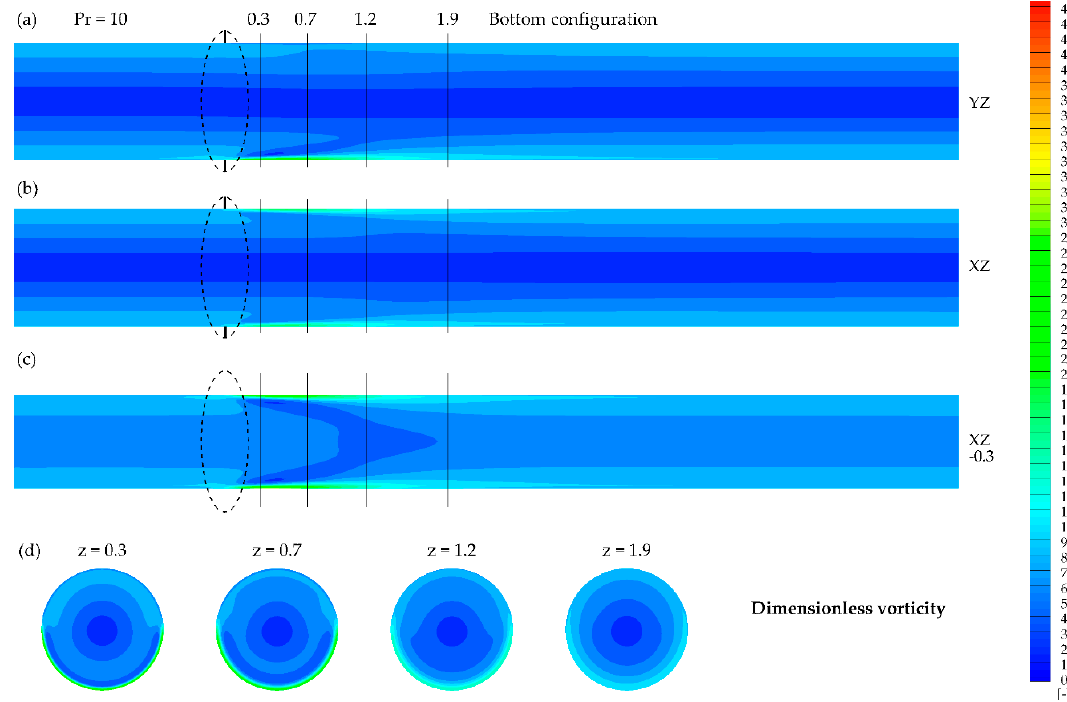
Figure 15. Dimensionless vorticity contours obtained for Pr = 10 and bottom configuration in the presence of the magnetic field at: ( a ) YZ plane, ( b ) XZ plane, ( c ) XZ plane ( y = − 0.3), ( d ) XY planes at given z .